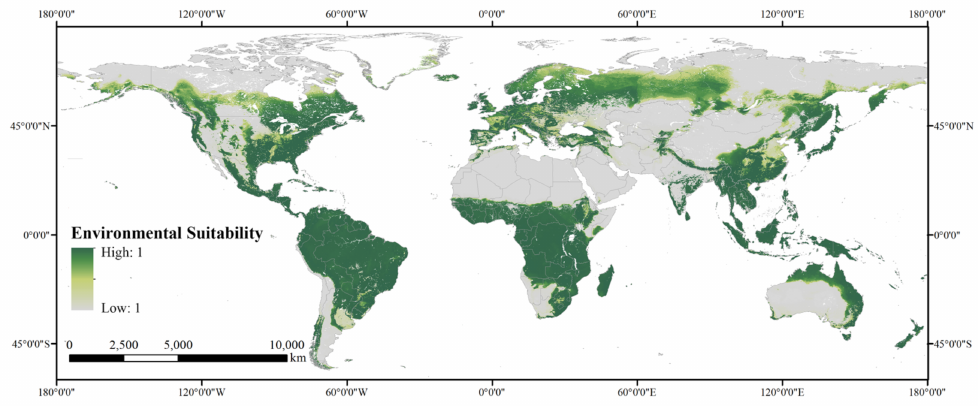
Figure 4. Global map of the predicted environmental suitability for giant